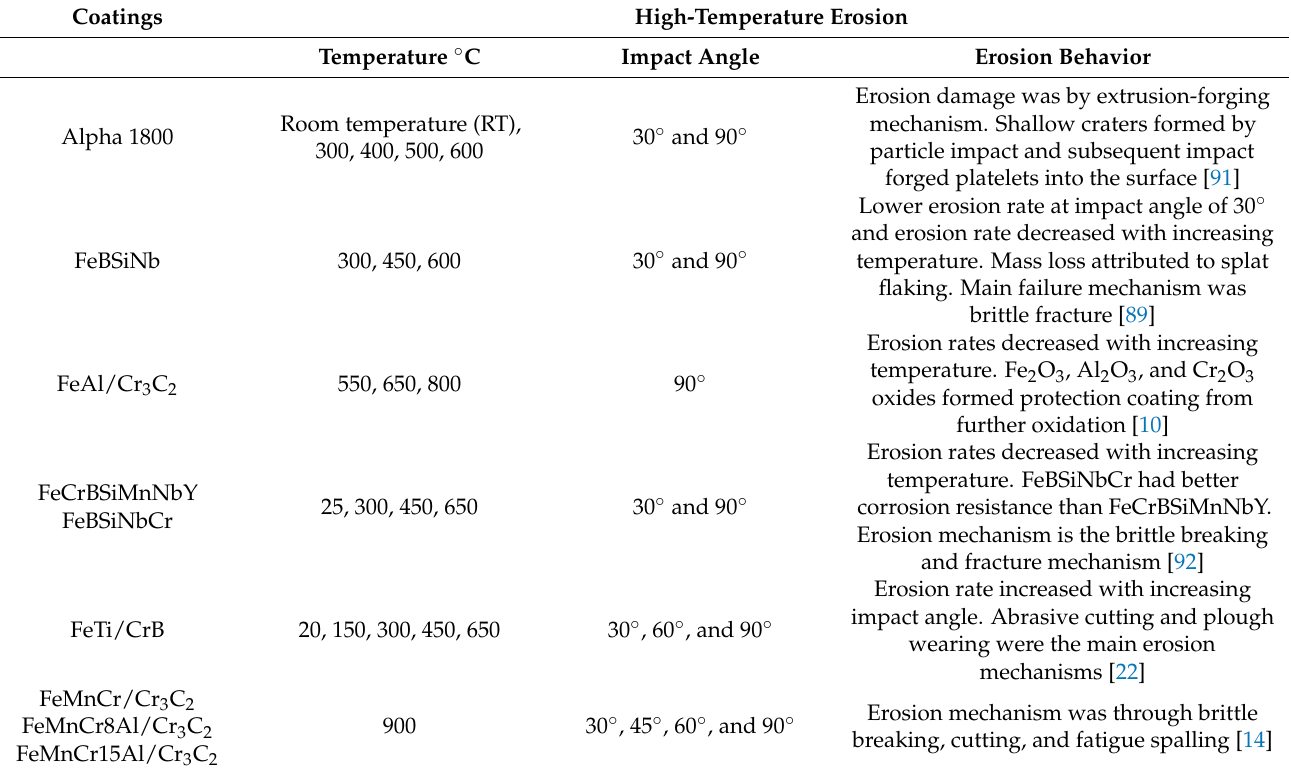
Table 5. Summary of the high-temperature erosion behavior of arc-sprayed Fe-based